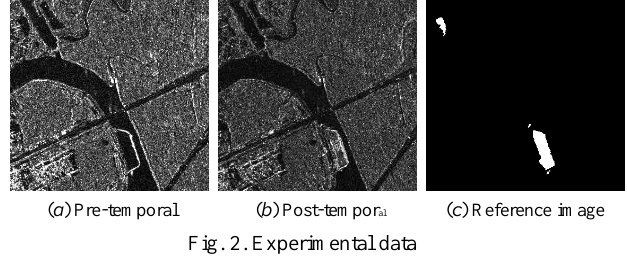
Fig. 2. Experimental